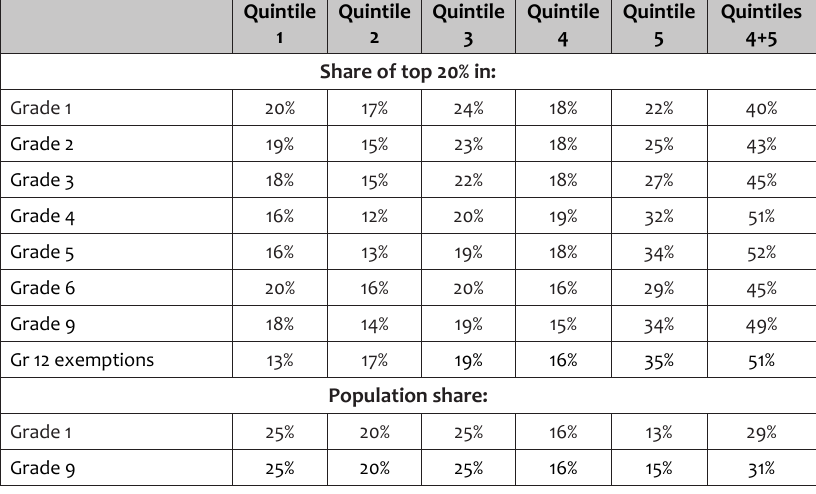
Table 4: Share of learners from different quintiles in top 20% of learner performance in each grade, ANA 2012 (Source: Own calculations from ANA data)